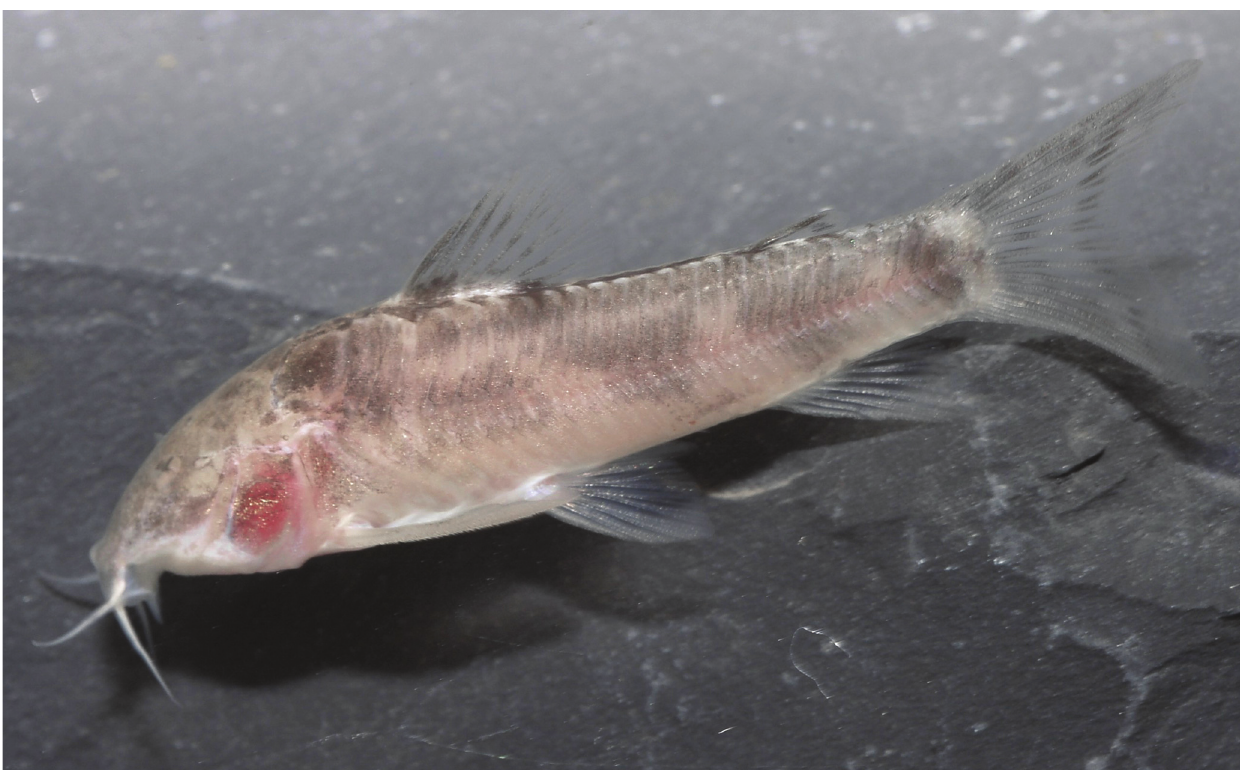
Fig. 1. Aspidoras albater , MZUSP 95905, about 25.0 mm SL, from Anésio III cave, Goiás, Brazil. Specimen kept in aquarium. Photo Alexandre Lopes